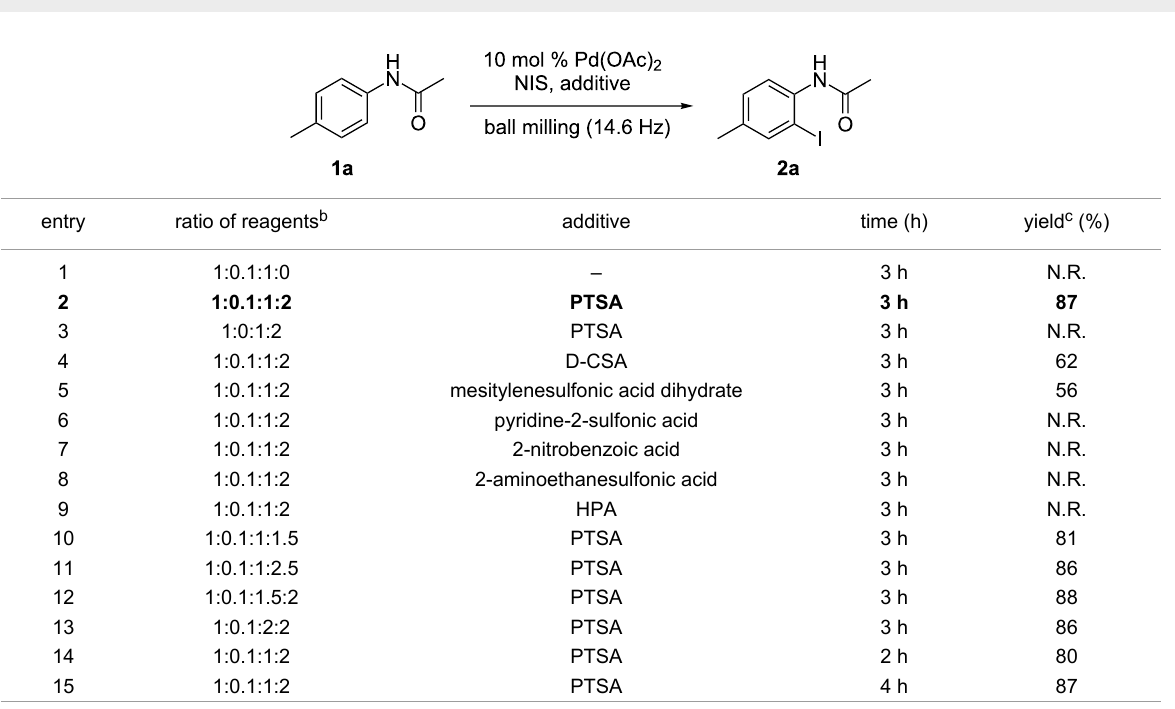
Table 1: Optimization of the reaction conditions.